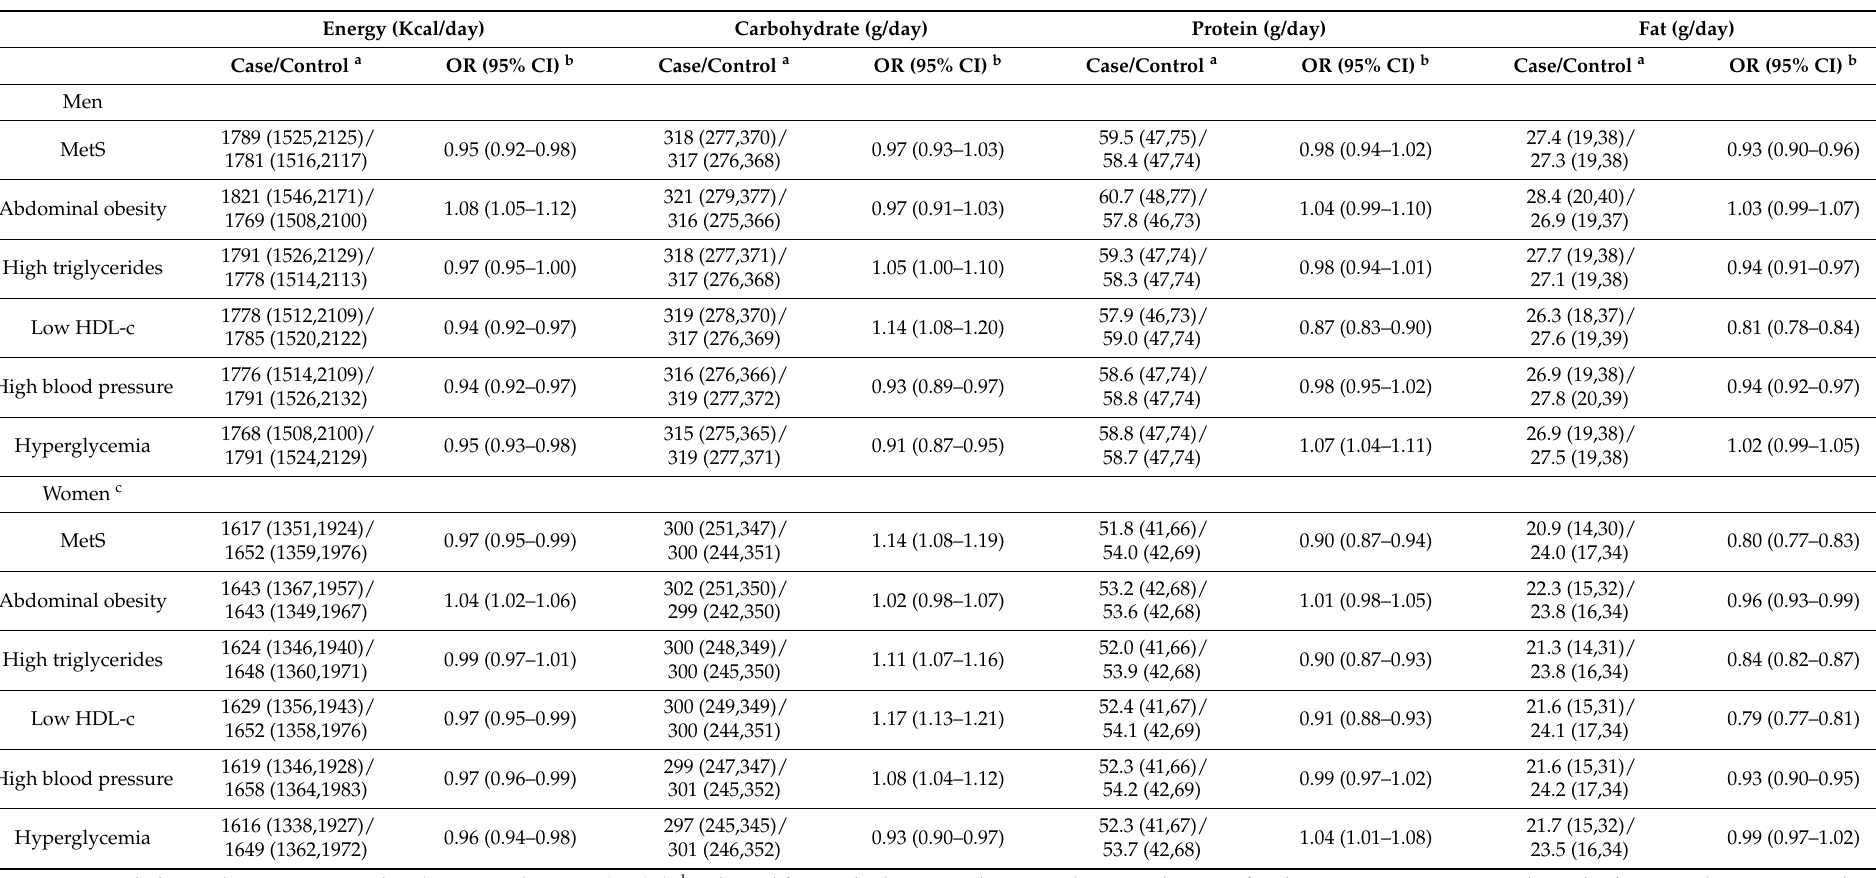
Table 2. Odds ratios (OR) and 95% confidence intervals (CI) of metabolic syndrome and its components according to macronutrient intake, the HEXA-G study, 2004–2013. Energy (Kcal/day) Carbohydrate (g/day) Protein (g/day) Fat (g/day) Case/Control a OR (95% CI) b Case/Control a OR (95% CI) b Case/Control a OR (95% CI) b Case/Control a OR (95% CI)